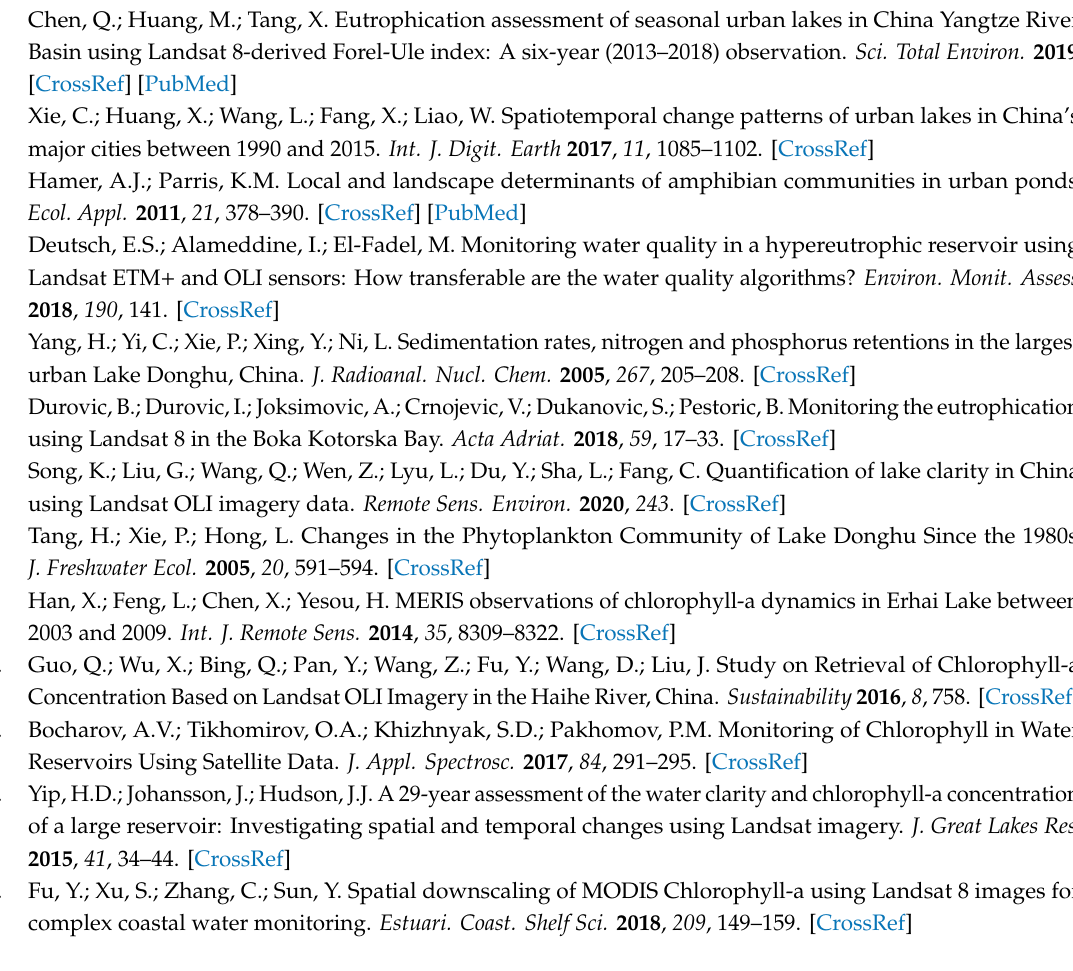
Figure S1. Comparison between the observed and predicted Chl-a and meteorological data from 2005–2018. Figure S2: Map of predicted Chl-a concentration distribution in the spring and autumn from 1987 to